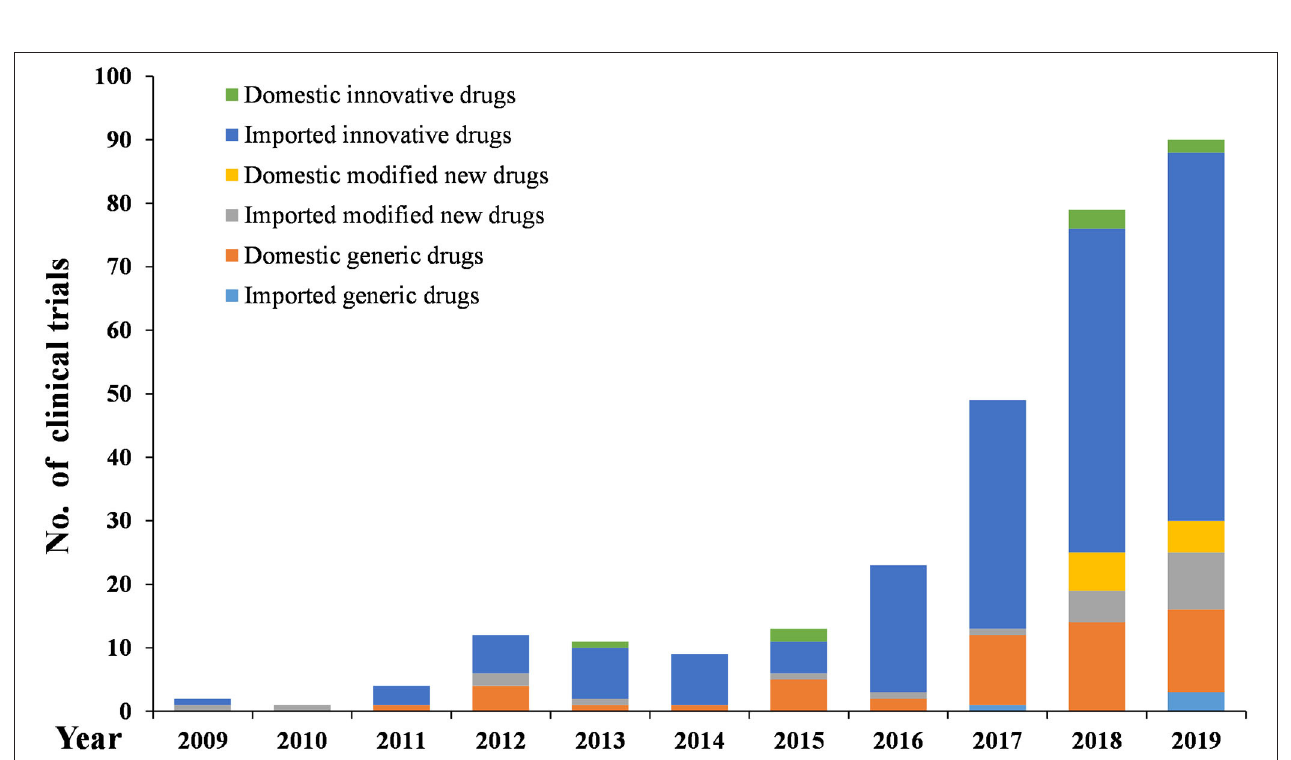
FIGURE 8 | Development trends of different types of chemical drugs in pediatric clinical trials.